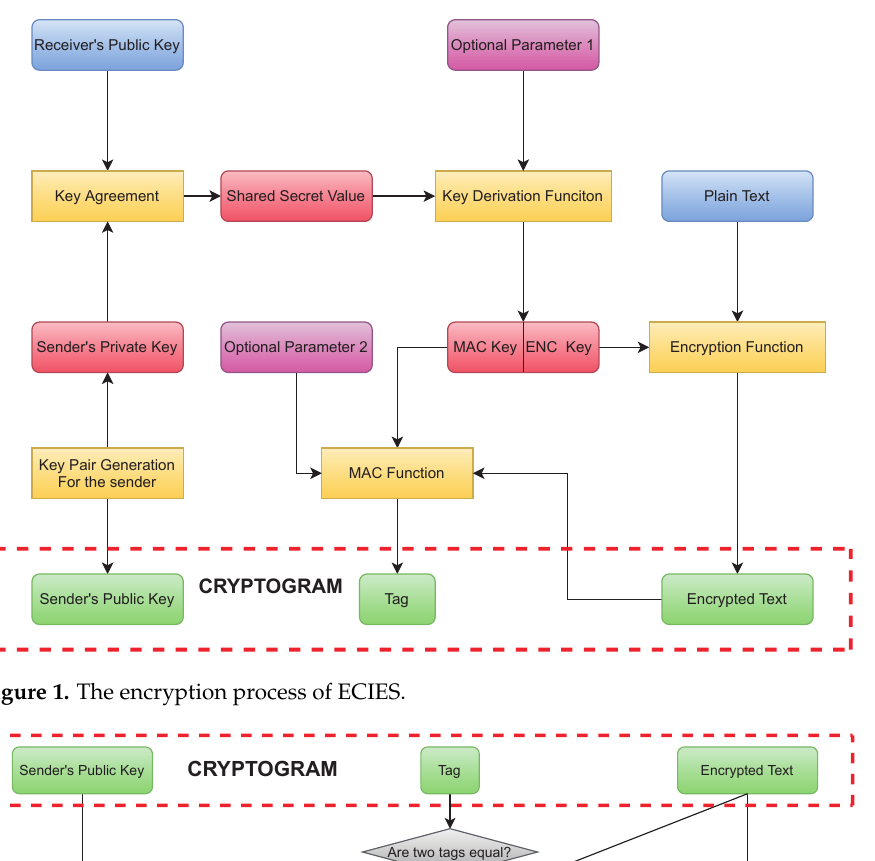
Figure 1. The encryption process of ECIES.